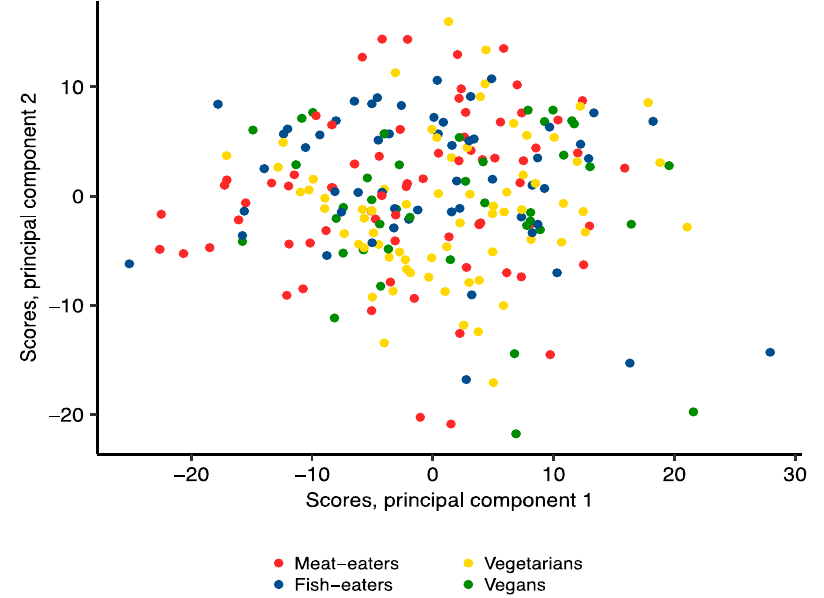
Figure 3. Score plot of principal component analysis of 207 NMR metabolite variables by diet group.